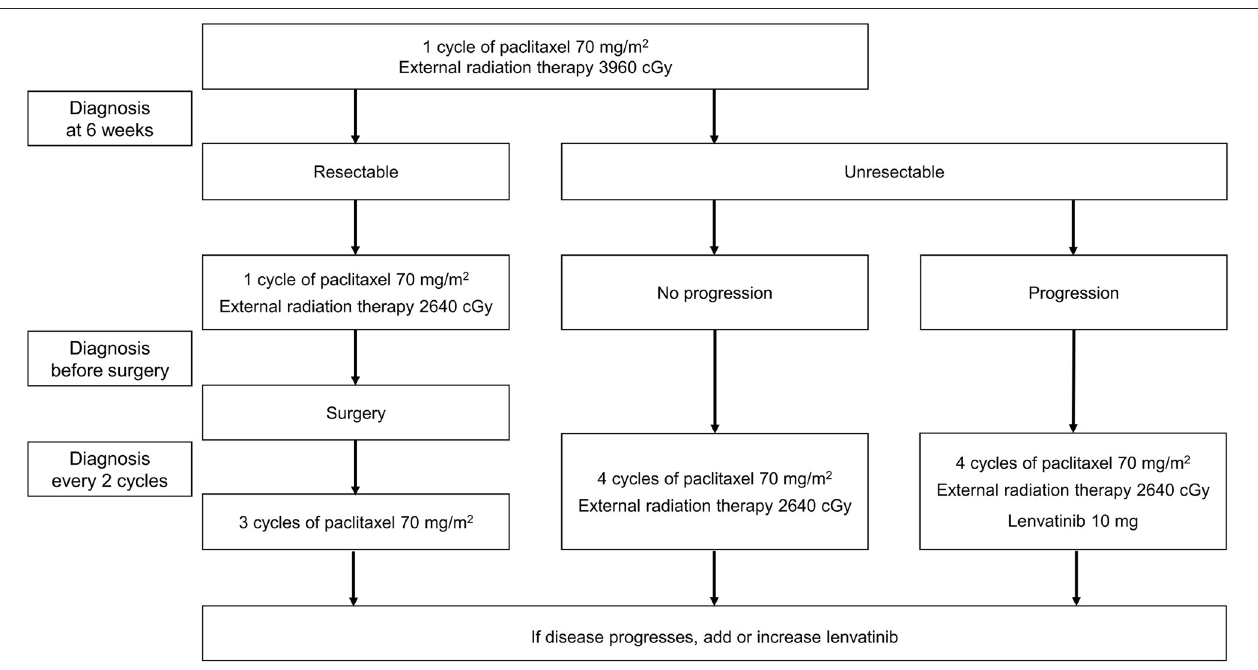
FIGURE 1 | Anaplastic thyroid cancer treatment protocol followed at the Gangnam Severance Hospital.